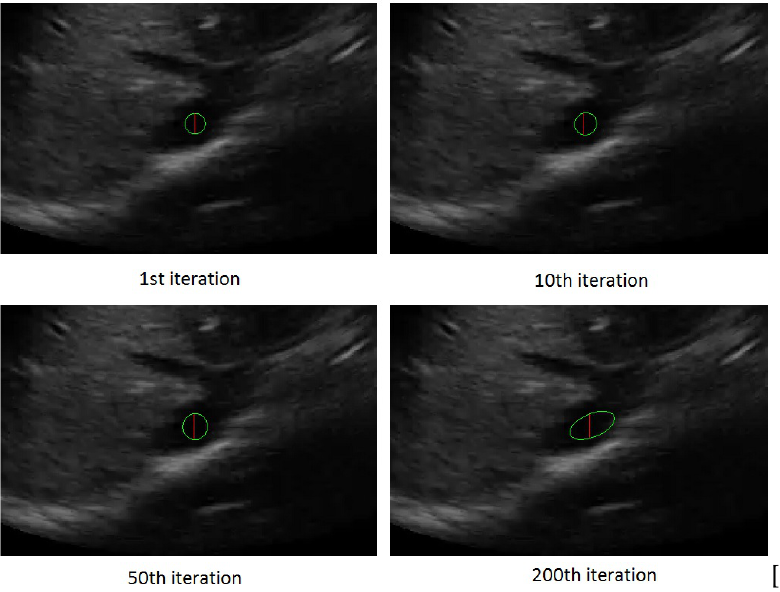
Figure 2. The rectangle evolution versus number of